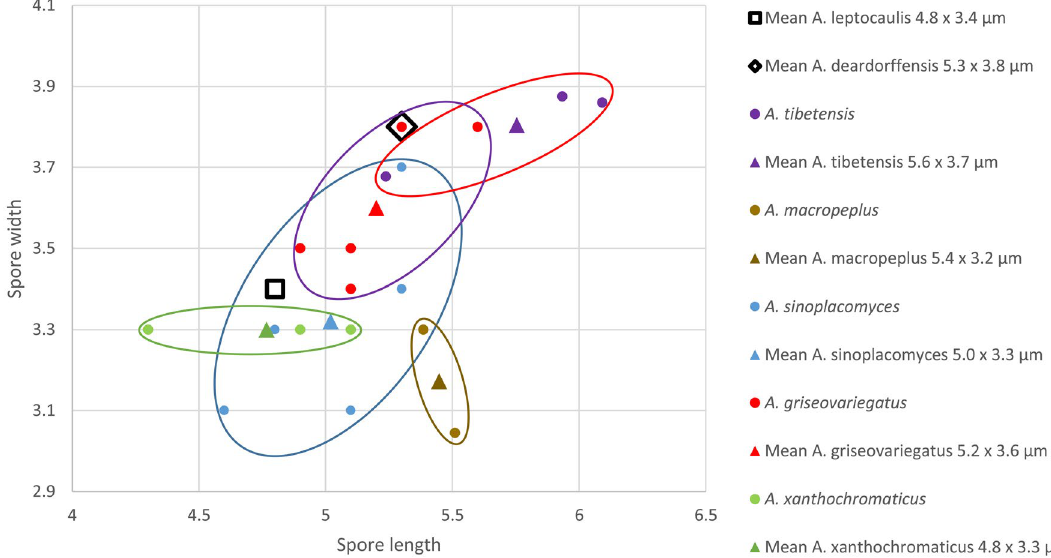
Figure 3. Graphical of spore size comparisons between seven closely related species including the three new species A . griseovariegatus , A. macropeplus , and A. xanthochromaticus .